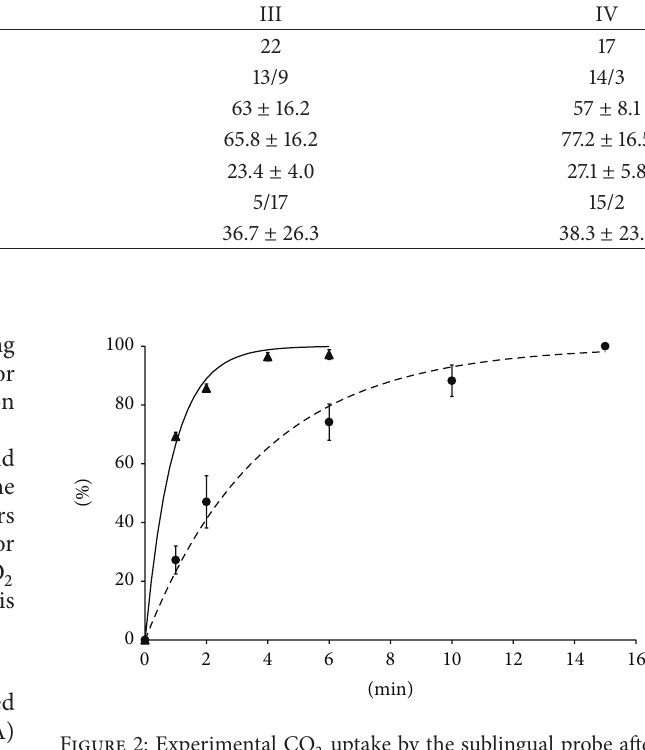
Figure 2: Experimental CO 2 uptake by the sublingual probe after given equilibration times. Values expressed as percentages of the reference data. In vitro at 37 ∘ C ( 󳵳 ), equation: 𝑦 = 100(1 − 𝑒 −1.101𝑥 ) , and in vivo ( e ), equation: 𝑦 = 100(1 − 𝑒 −0.265𝑥 )